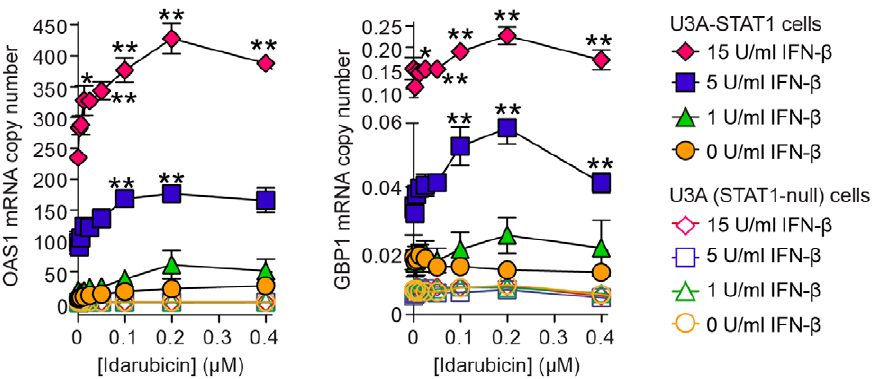
Figure 7. Idarubicin induces STAT1-dependent gene expression. U3A-STAT1 and U3A (STAT1-null) cells were treated with idarubicin for 1.5 h followed by IFN- b for 12 h and then determination of OAS1 and GBP1 mRNA levels using real-time quantitative PCR assay. Overall significance for idarubicin dose p , 0.0001, IFN- b dose p , 0.0001, and interaction p , 0.0001. The p-values for individual comparisons (vs 0 idarubicin control) are from Bonferroni post-tests from two-way ANOVA (idarubicin x IFN dose). Symbols: * p , 0.01, ** p , 0.001.